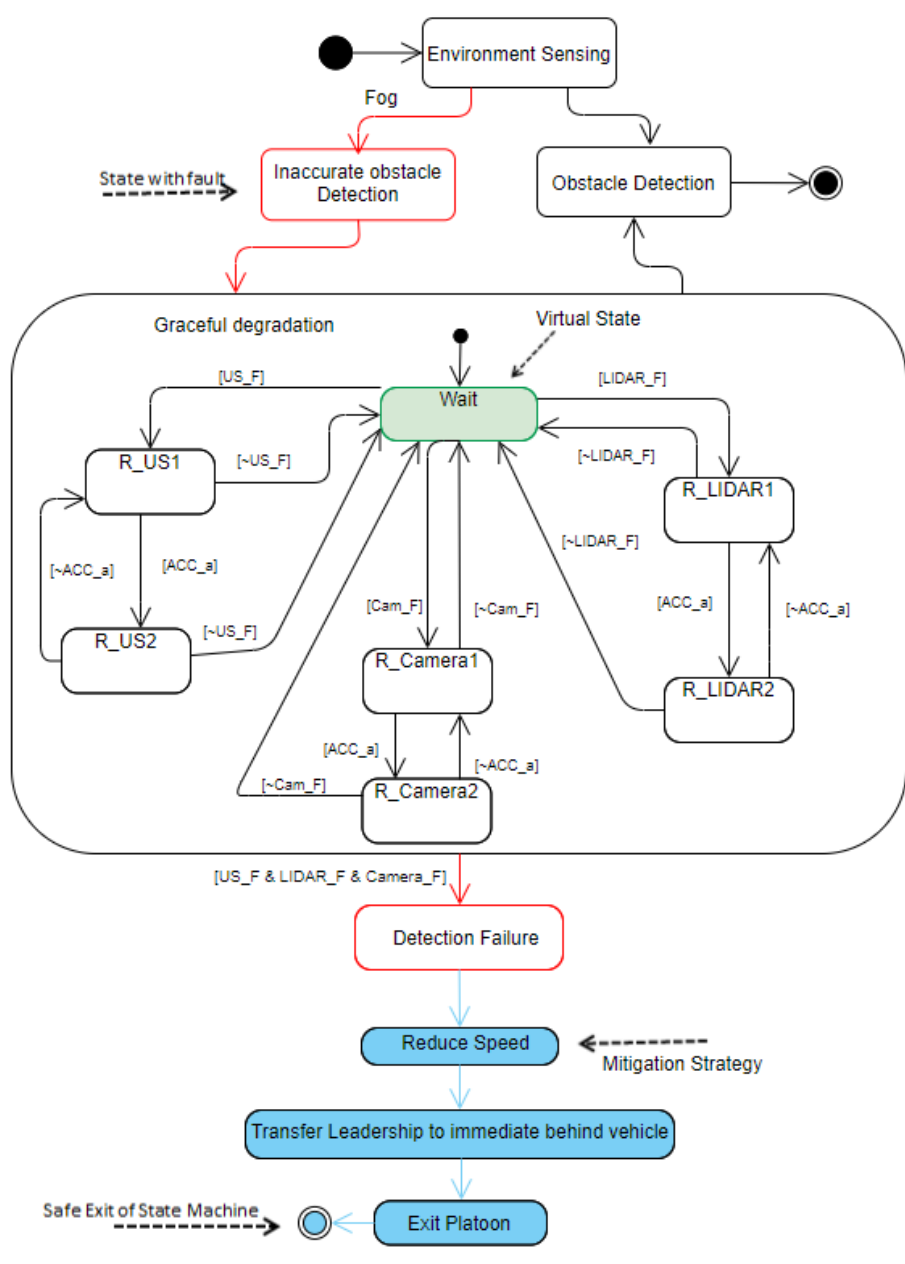
Figure 9. Resilient state transition for perception failure due to fog.